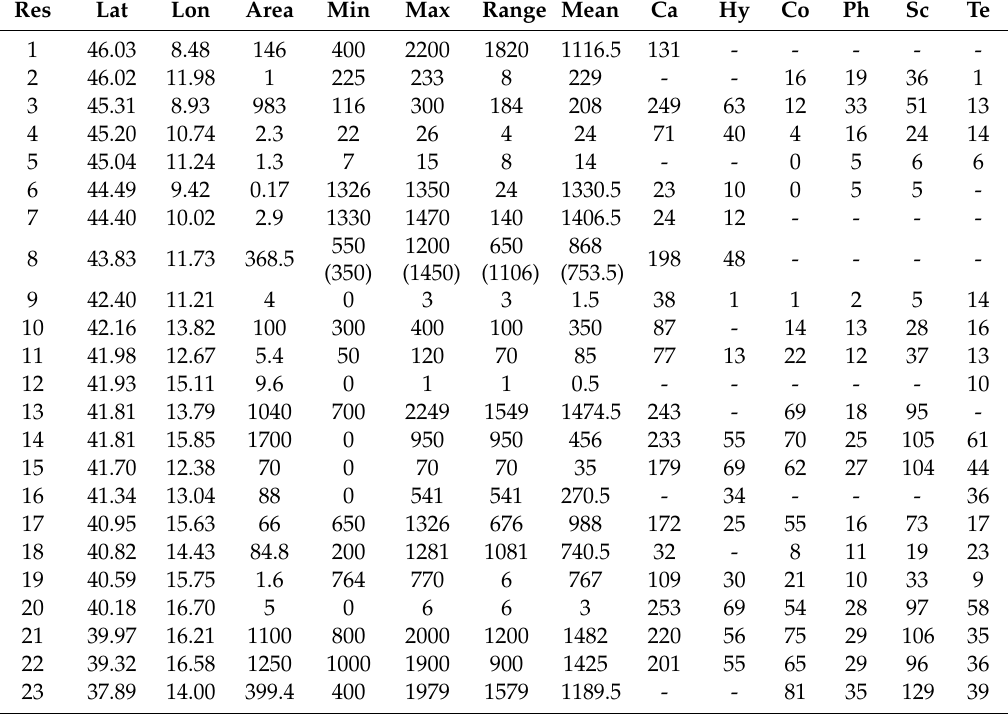
Table 1. Number of species for various beetle groups in Italian reserves. Res: Reserve number 1 (reserves are numbered as in Figure 1); Lat: Latitude (decimal degrees); Lon: Longitude (decimal degrees); Area: reserve size (km 2 ); Min: Minimum elevation (m); Max: Maximum elevation (m); Range: Elevational range (m); Mean: Mean elevation (m). Beetle groups: Ca: Carabidae; Hy: Hydradephaga; Co: coprophagous Scarabaeoidea; Ph: phytophagous Scarabaeoidea; Sc: all Scarabaeoidea; Te: Tenebrionidae. For reserve 8, elevational data without parentheses refer to Carabidae sampling points, and those in parentheses to Hydradephaga sampling